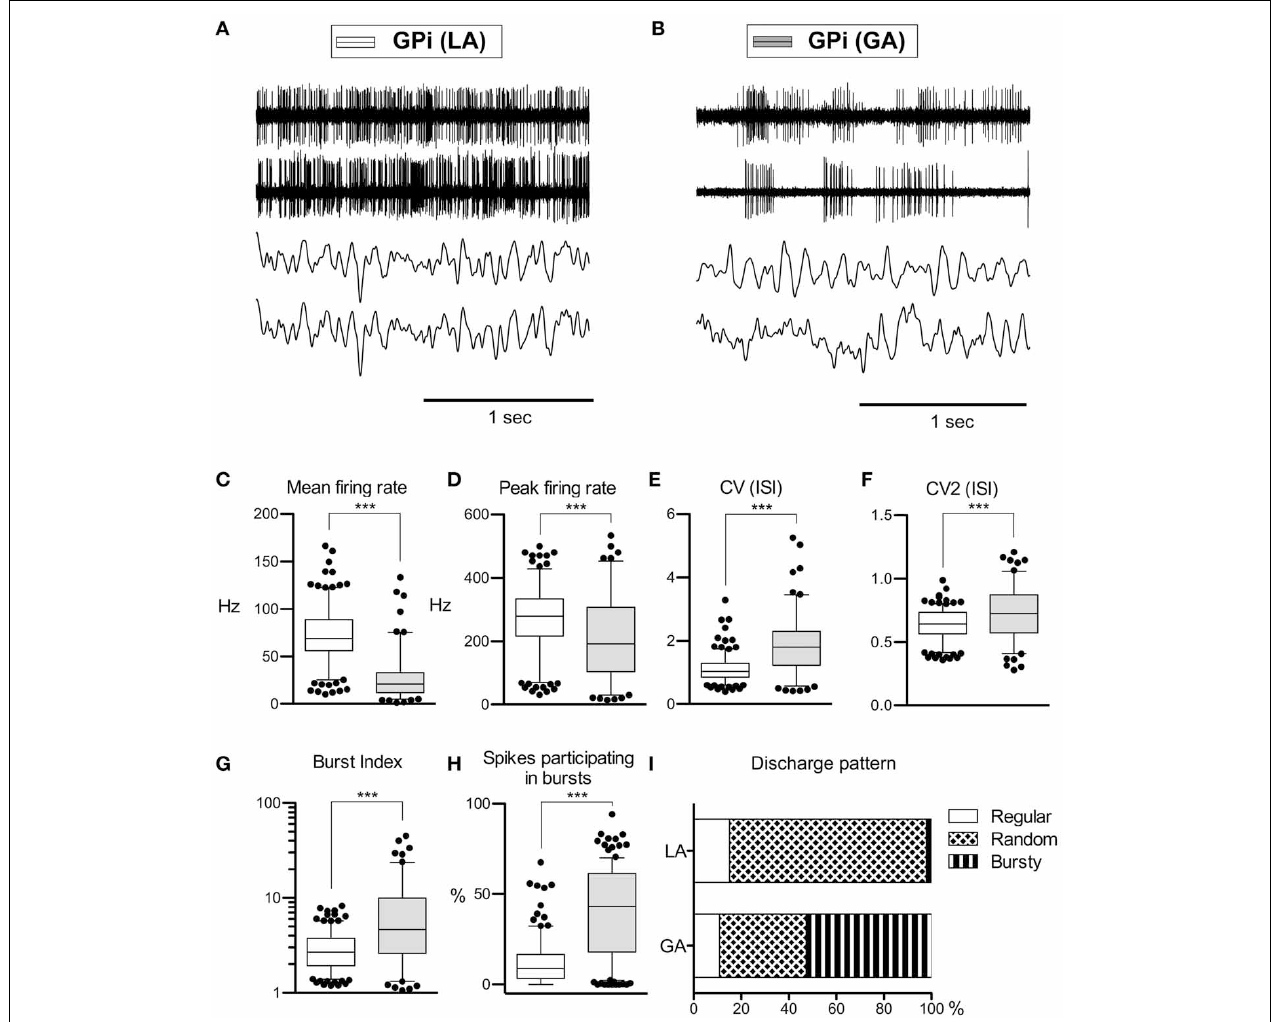
FIGURE 2 | Comparison of discharge rates and patterns of neurons under LA and GA in the GPi of CD patients. (A) Simultaneously recorded raw spike trains and LFP data from the ventral GP of case 7 (operation under LA). (B) Raw traces from two representative GPi neurons recorded under GA